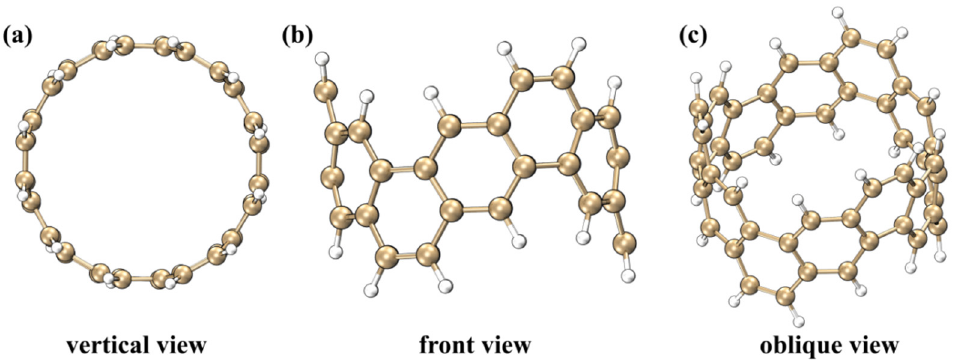
Figure 1. Top view ( a ), front view ( b ) and oblique view ( c ) of [6, 6] CNB. The golden balls represent carbon atoms, and the white balls represent hydrogen atoms.